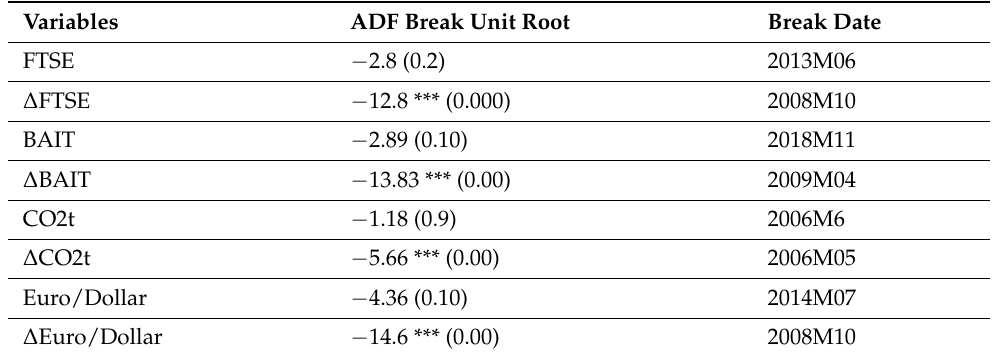
Table 2. ADF break unit root